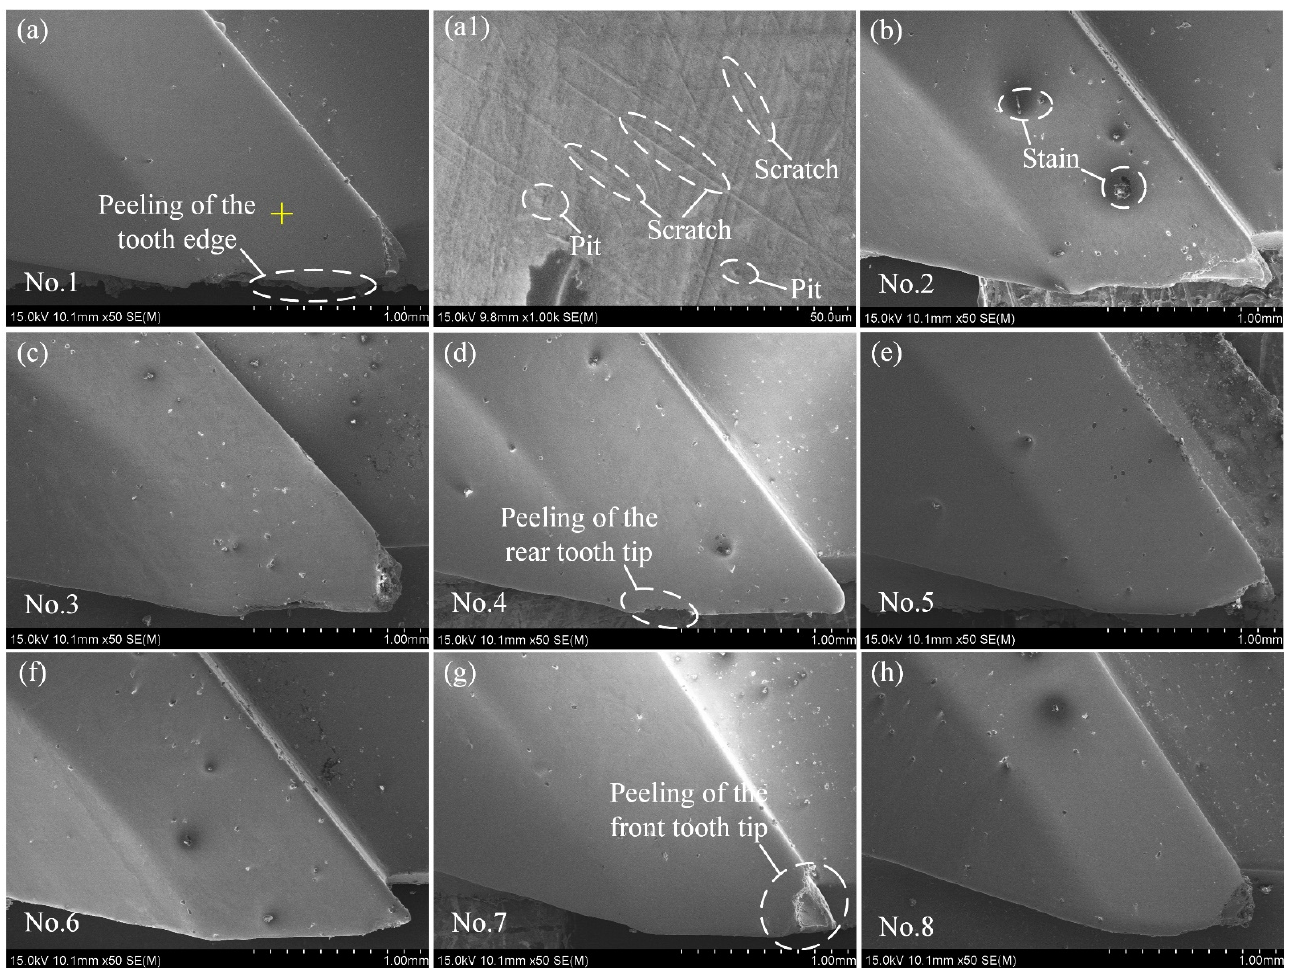
Figure 7. Wear morphology of hook teeth nos. 1 to 8 in a 300-hectare operation: ( a – h ) Wear morphology of hook teeth nos. 1 to 8; and ( a1 ) partial micrograph of the hook tooth nos. 1 mark.